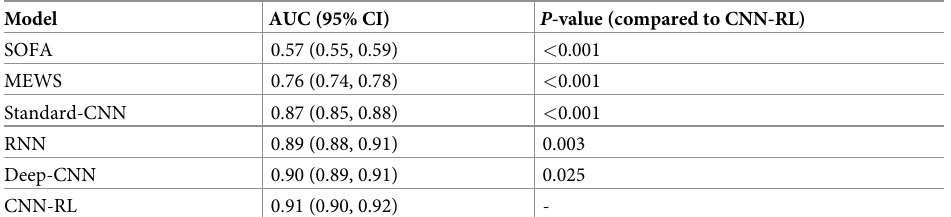
Table 2. Model discrimination for predicting mortality on the test dataset (n = 34,747 admissions). Model